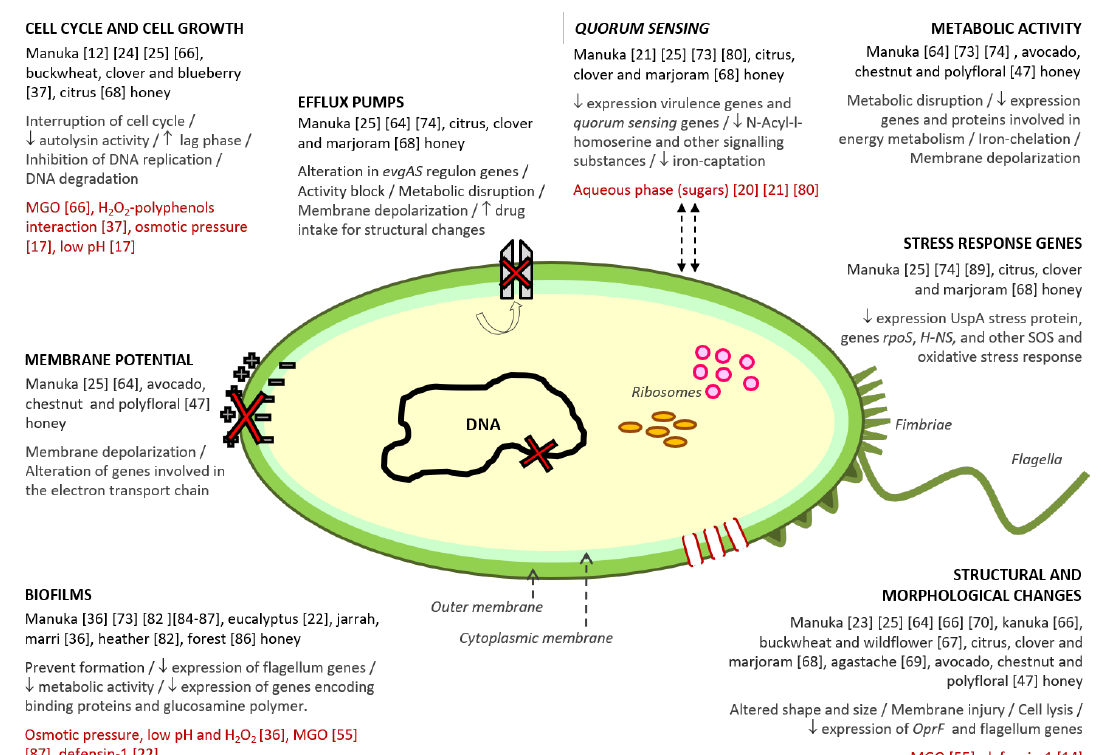
Figure 1. Antibacterial action mechanisms described for honey. Within each mechanism, the following information has been collected: (i) varieties of honey in which the mechanism was detected; (ii) the different effects related to the mechanism; (iii) the compound/s or honey characteristics associated to the mechanism, and (iv) the reference number of the studies from which the information was extracted.